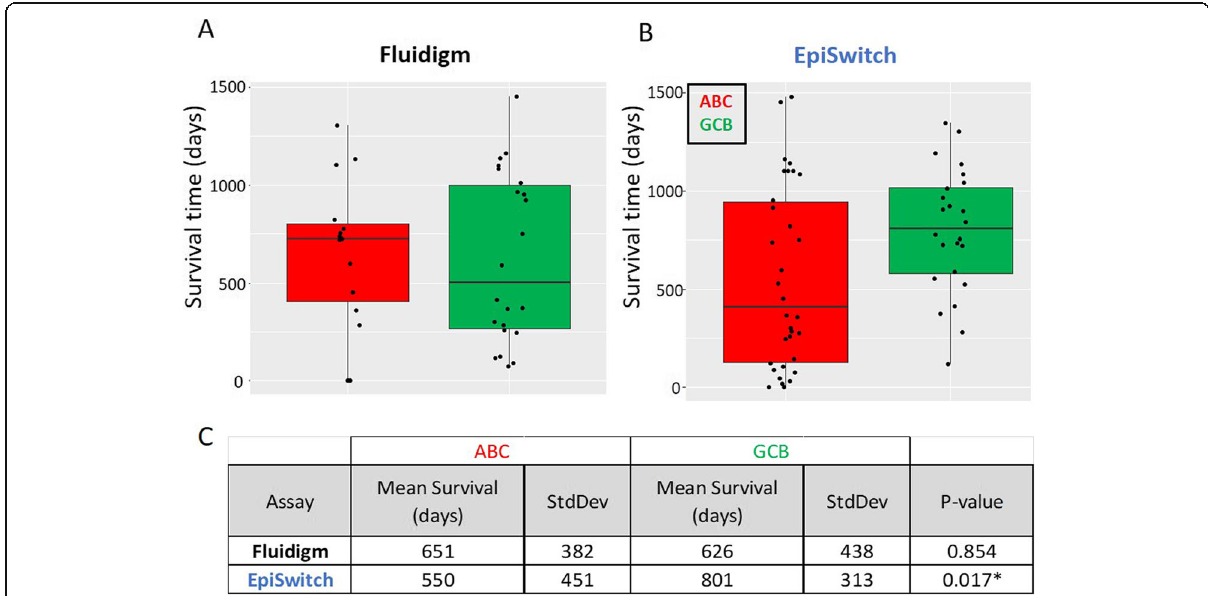
Fig. 6 Mean survival time by EpiSwitch and Fluidigm classification in the Validation cohort. Mean survival times of the patients classified as either ABC (red) or GBC (green) by the Fluidigm assay (A) or the EpiSwitch assay (green). There was a statistically significant difference in the mean survival time of the ABC (550 days) and GCB (801 days) samples called by the EpiSwitch classifier. StdDev = Standard deviation